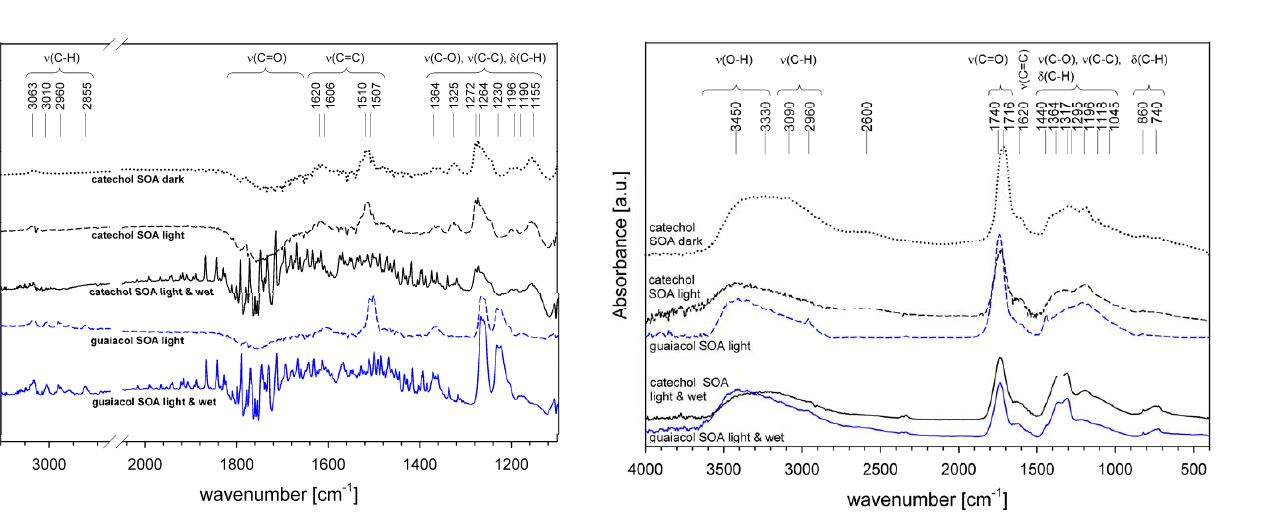
Fig. 6. Time resolved long path FTIR spectra of SOA formation from catechol with ozone in the dark: The well defined chemical structure of the precursor migrates to the broad rather undefined structure of macromolecular organic substances. Assignments of the observed bands are listed in Table 1.